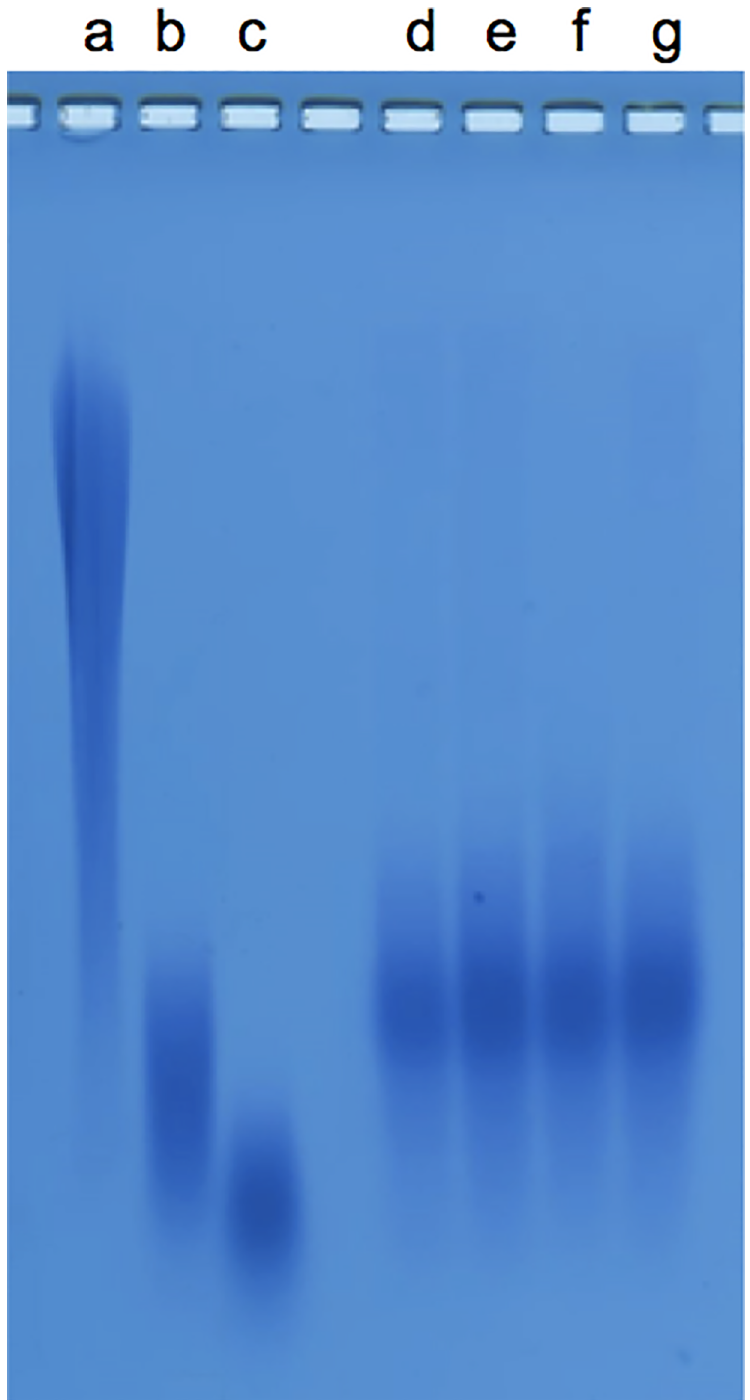
Fig 2. Profile migration of PGA (Poly-g-glutamate) on 0.8% agarose gel electrophoresis. (a) commercial γ -PGA (Sigma Aldrich, G1049); (b) commercial PGA 3–15 kDa (Sigma Aldrich, P4636); (c) commercial PGA 15–50 kDa (Sigma Aldrich, P4886) and PGA extracted from the supernatant of Bacillus subtilis growth (d) after no exposure and (e) after exposure to silver nanoparticles (n-Ag), (f) to n-Ag2S or (g) to Ag lactate.